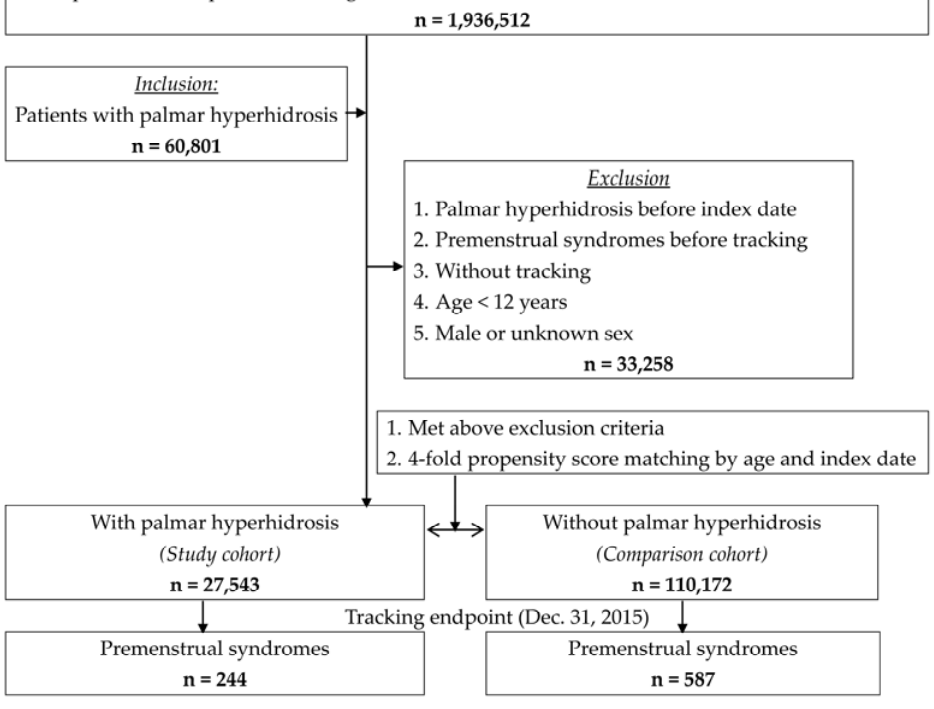
Figure 1. Flowchart of this study.